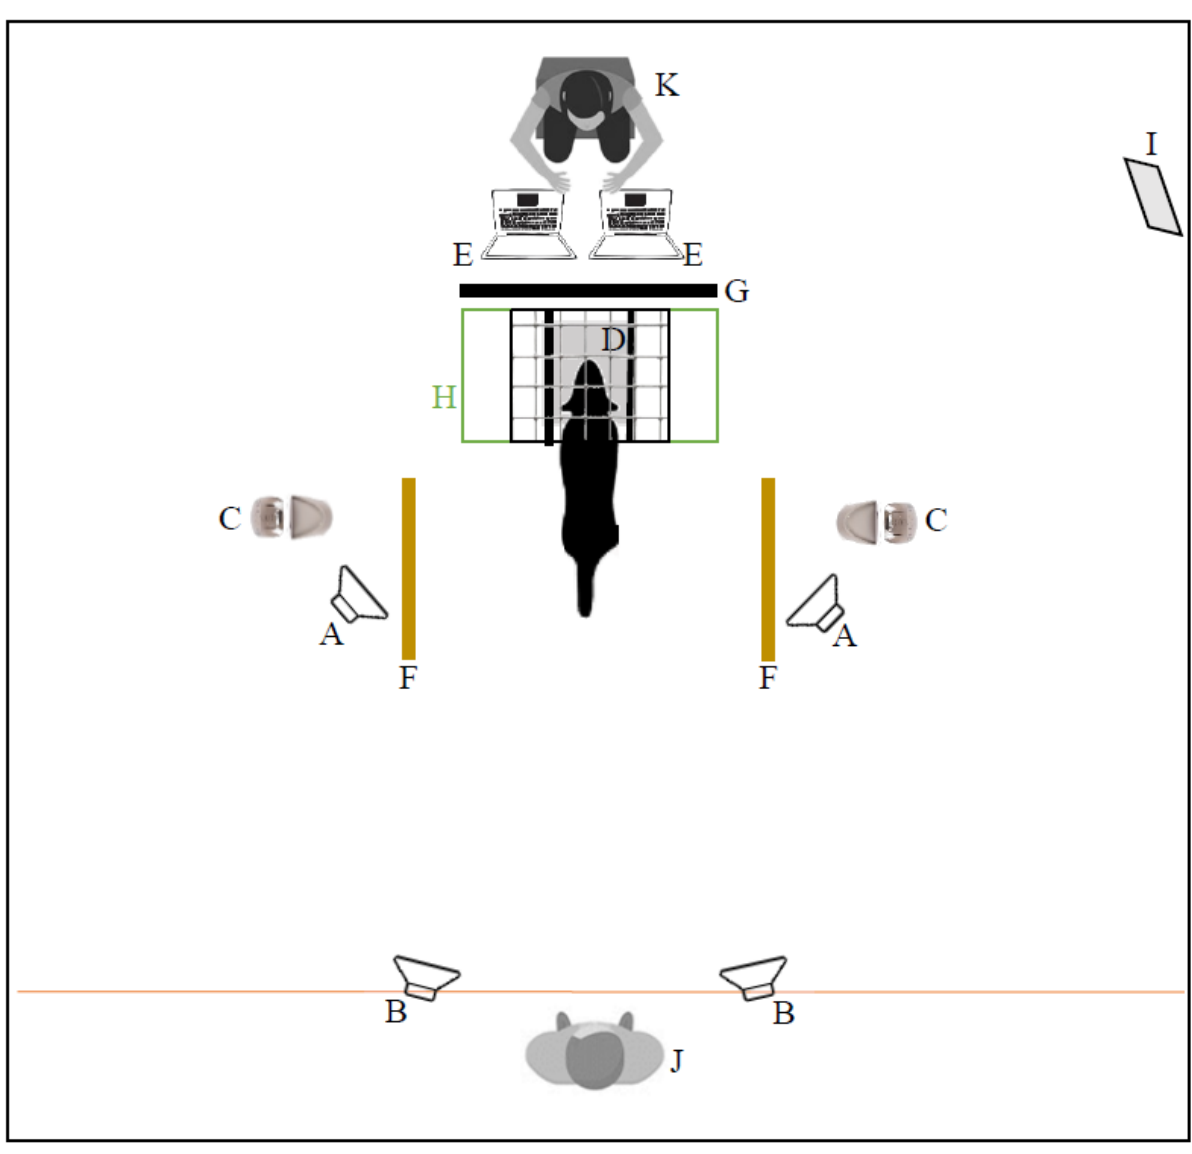
Figure 1. Schema of the room and spatial position of experimental elements from above. A, training speakers (fixed); B, testing speakers (movable); C, food dispensers; D, headrest; E, computers triggering sound; F, line defining dog’s choice; G, panel separating sound operator from dog’s view; H, apparatus; I, mirror; J, dog operator; K, sound operator.